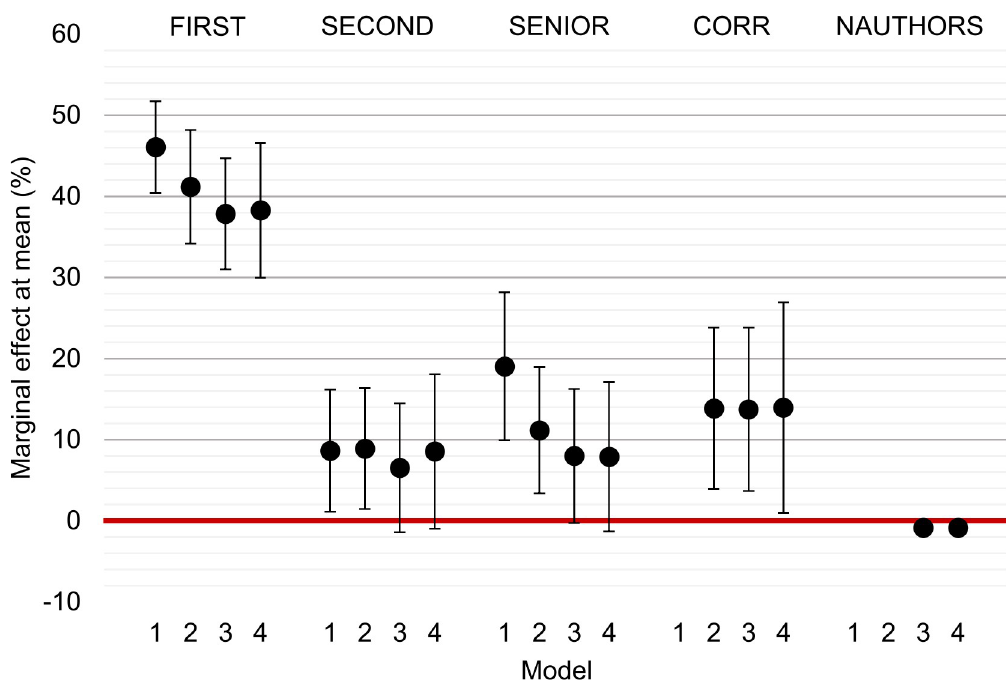
Fig 3. Coefficient plot of Probit regression of author position on responsibility. The dots indicate the predicted marginal effect of the model variables on the probability of being responsible for scientific misconduct at the sample mean. The error bars indicate 95% confidence intervals of the marginal effect. The underlying model is a Probit regression model. Standard errors are clustered by misconduct case. The estimates are grouped by model. Model one includes FIRST, SECOND, SENIOR, and a constant. The coefficients represent the added probability of being found responsible compared to middle authors, the reference group. Model two includes a variable for corresponding authorship, CORR. Model three controls for the number of authors on the publication (NAUTHORS) and includes a set of year indicators. Model four follows the same specification as model three but limits the sample to those where the responsible author did not deny or appeal ORI’s findings. Across all models, first authors remain significantly more likely to be responsible than middle authors. Senior authors are also more likely to be responsible in model one and two, but this effect turns insignificant once CORR is added to the analysis. Note that the 95% confidence intervals for NAUTHORS are small: [-1.3%—-0.4%] for both models where they are